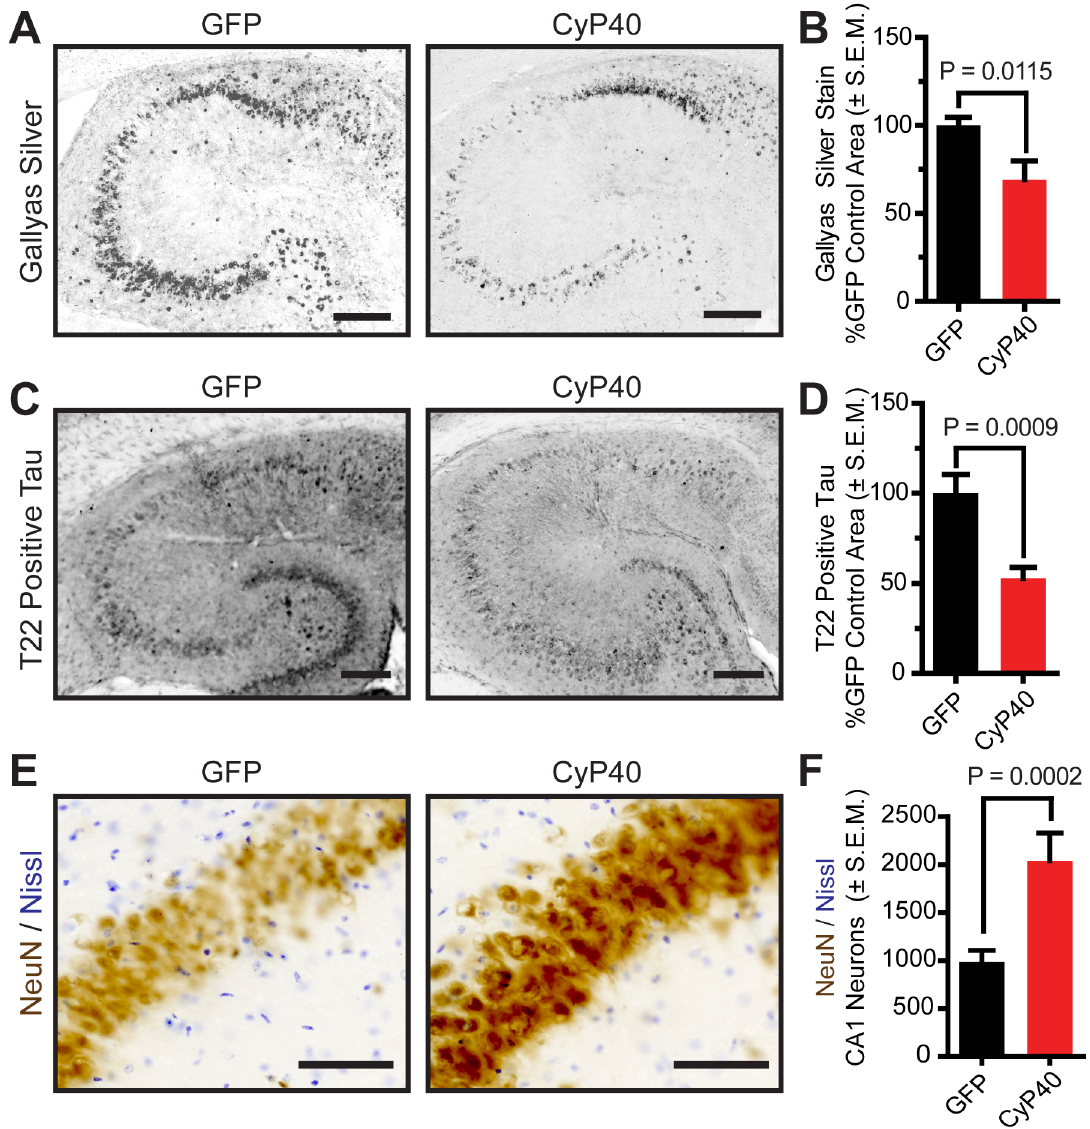
Fig 3. Cyclophilin 40 (CyP40) reduced tau deposits and preservedhippocampal CA1 neurons in vivo. (A) Representative images of Gallyas silver-stainedhippocampi from adeno-associated virus serotype 9–greenfluorescent protein (AAV9-GFP) and AAV9-CyP40injectedmice (scale bar 200 μ m). (B) Quantification of Gallyas silver-staining (unpaired t test, n = 8 for each group) (C) Representative images of T22-oligomeric tau stainedhippocampi from AAV9-GFP and AAV9-CyP40 injectedmice (scale bar 200 μ m). (D) Quantificationof T22-oligomeric tau staining(unpaired t test, n = 8 for each group) (E) Representative images of CA1 neuronsstainedwith NeuN (brown) and Nissl (violet) are shown (scale bar 125 μ m). (F) Neuroncounts from unbiased stereologyof CA1 neuronsin hippocampal sections from AAV9-GFP and AAV9-CyP40 injectedmice (unpaired t test, n = 8 for each group). The numericaldata used in panels 3B, 3D, and 3F can be found in S1 Data. SEM, standard error of the